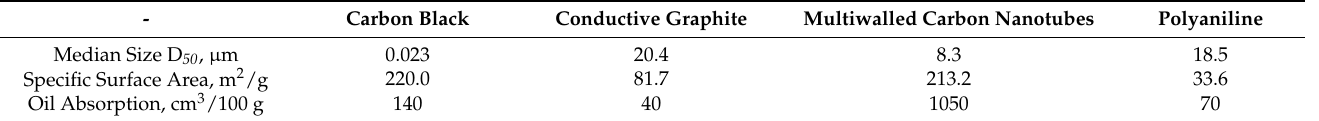
Table 1. Properties of the four different anti-corrosive conductive